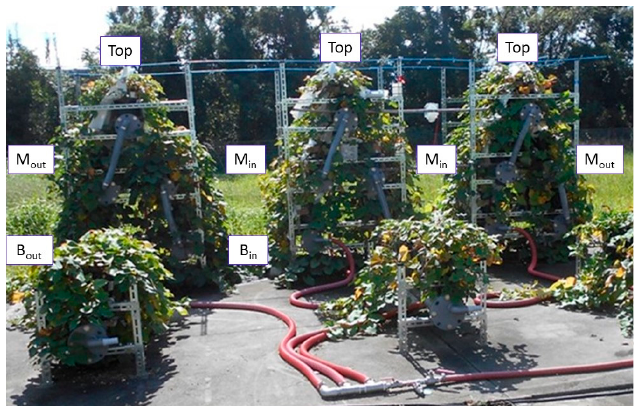
Figure 11. Position notations of the three-layer cultivation system: Top, top layer, M out , middle layer outside, M in , middle layer inside, B out , bottom layer outside, B in , bottom layer inside. The monolayer cultivation system in the foreground is for comparison.